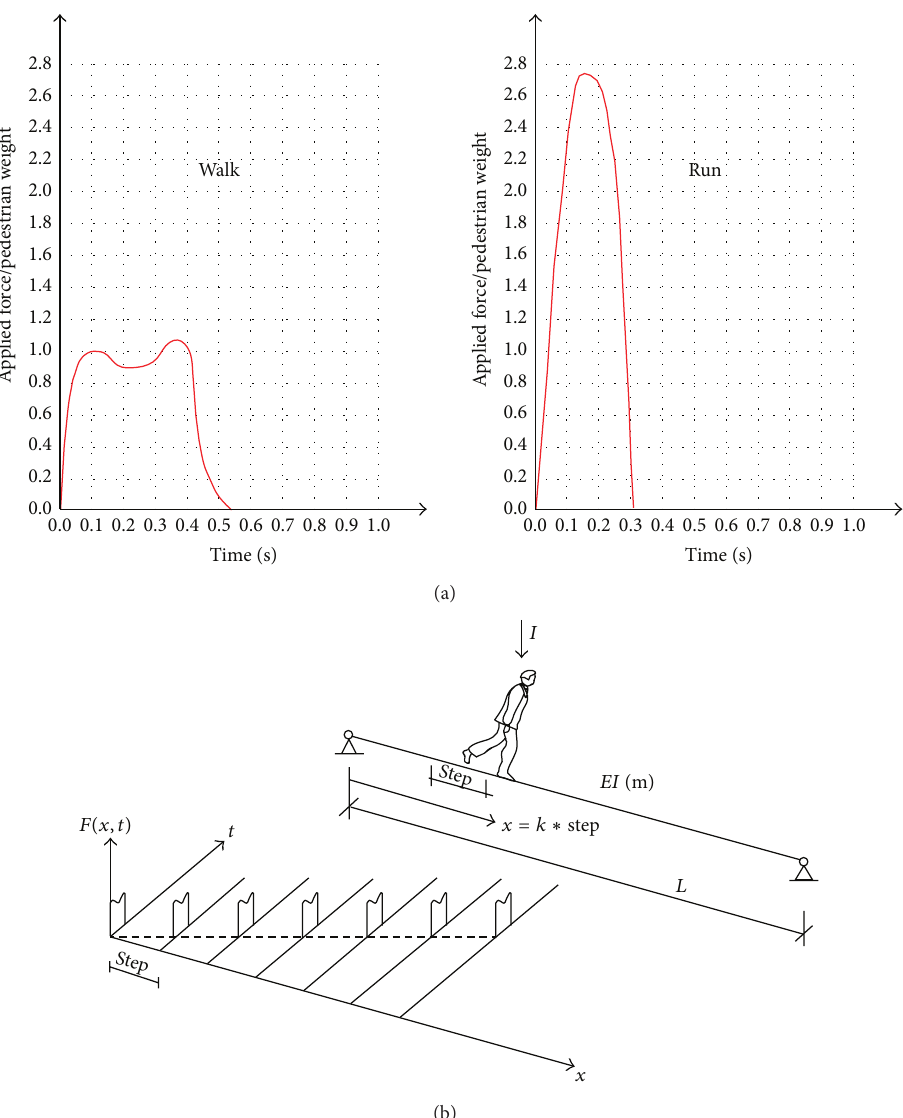
Figure 7: (a) Force-time typical diagram for different movements: left-step frequency < 2.2 Hz, right-step frequency > 2.2 Hz; (b) variation in time-space imposed by the walking movement [15].